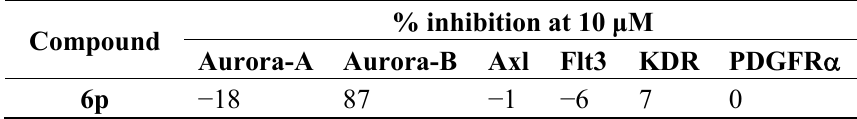
Table 3. Kinase inhibitory assays of 6p .